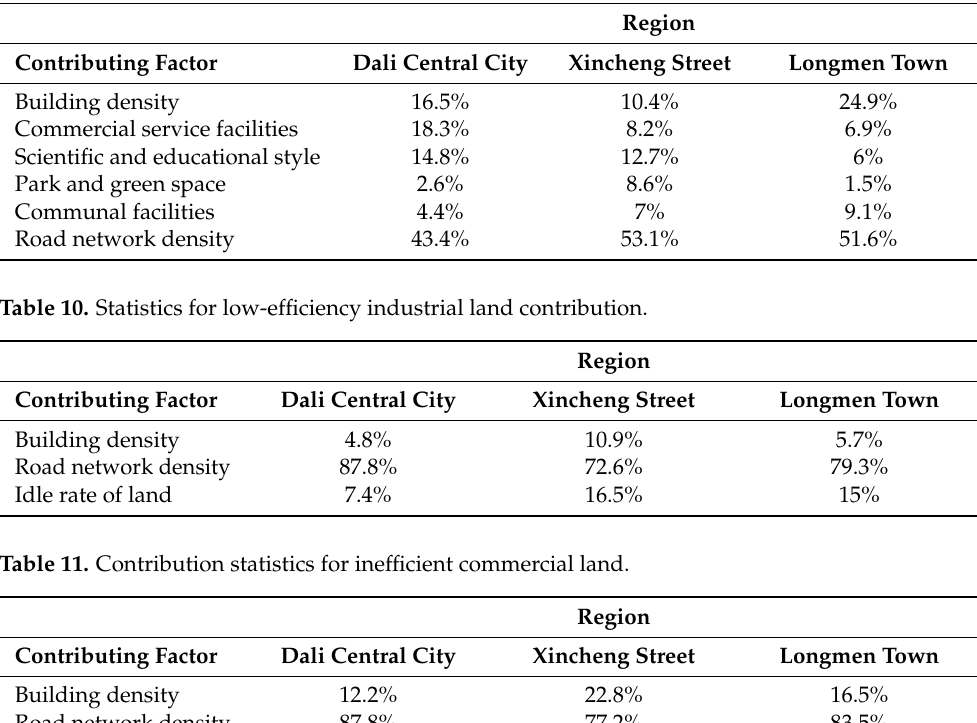
Table 9. Contribution statistics of inefficient residential land.